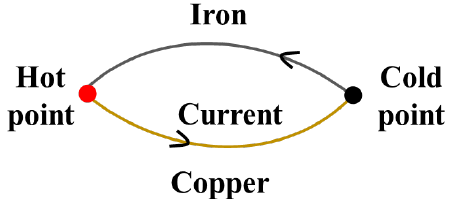
Figure 1. A simple schematic of Seebeck effect.